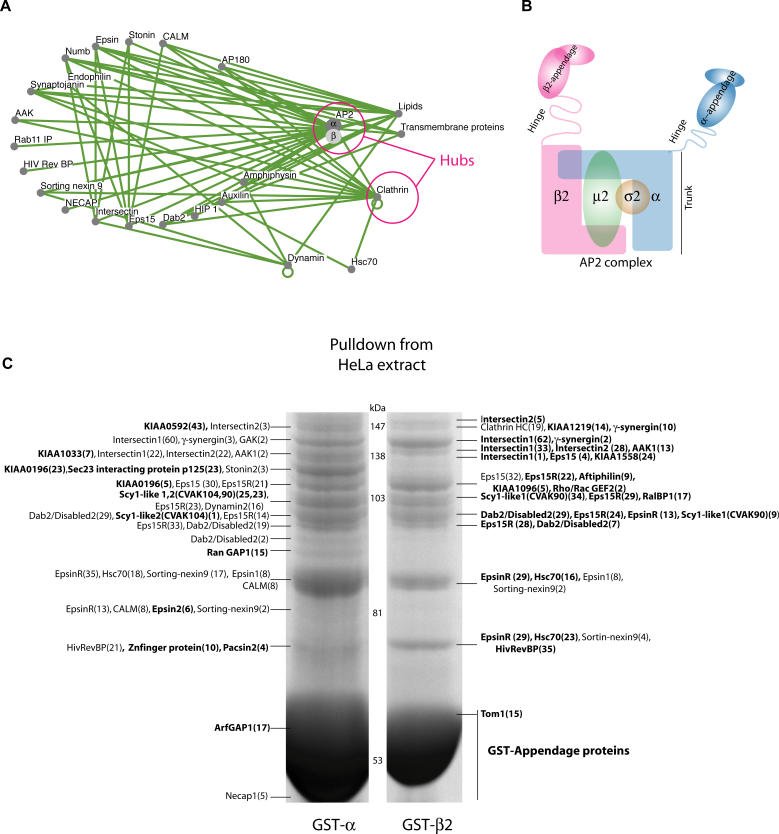
New Protein Interaction Partners for the α- and β-Appendage Domains of AP2 Adaptors(A) Plot of the network of protein interactions in clathrin-mediated endocytosis. AP2 adaptors and clathrin have disproportionately large numbers of interactors and so are the hubs of this network. Dynamin is a “party” hub as it is shared between different networks but we have not included all its interactors.(B) Scheme of AP2 showing the overall domain architecture and the appendages where most of the protein interactors bind are located on flexible linkers called “hinges.”(C) Protein interactors of α- and β2 appendages from HeLa cells as determined by LC-MS/MS of Coomassie stained bands. Bolded proteins were not detected previously. The interaction of CVAK104 and CVAK90 were tested and confirmed by yeast-2-hybrid analysis. The numbers of peptides sequenced from each protein are given in brackets. Further mass spectrometry data from brain and liver samples, accession numbers, domain structures and details are given in Figures S1 and S2.